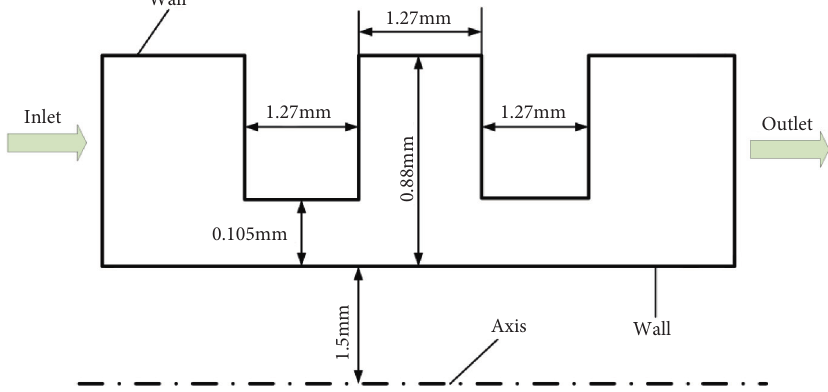
Figure 5: The experimental see-through labyrinth seal [32].